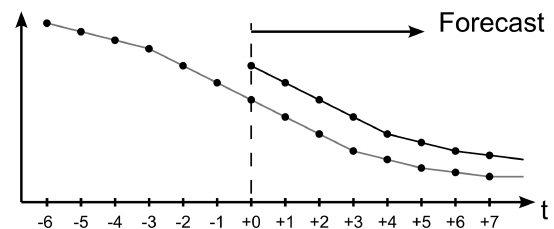
Figure 2. Conceptual example of meteorological forcing for ocean model with “hotstart” coinciding with the epoch. It is assumed that the ocean model uses linear interpolation between the available me- teorological